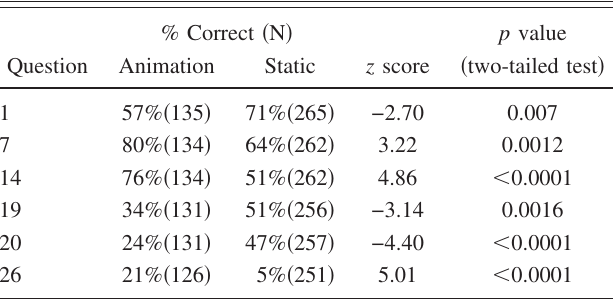
TABLE I. Results for questions where significant differences were found in performance. The actual number of students answer- ing each question varied because not every student answered every